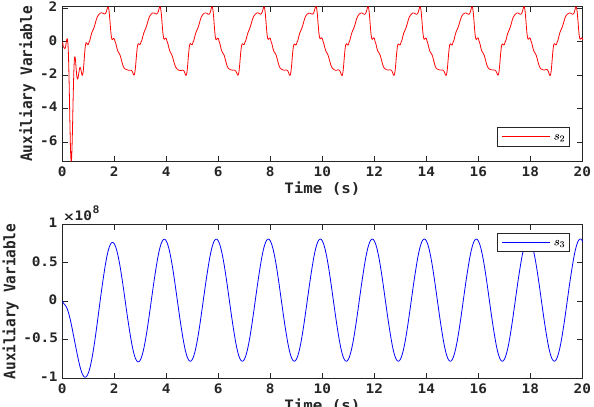
Figure 13. The dummy control variables of the VSDO in the